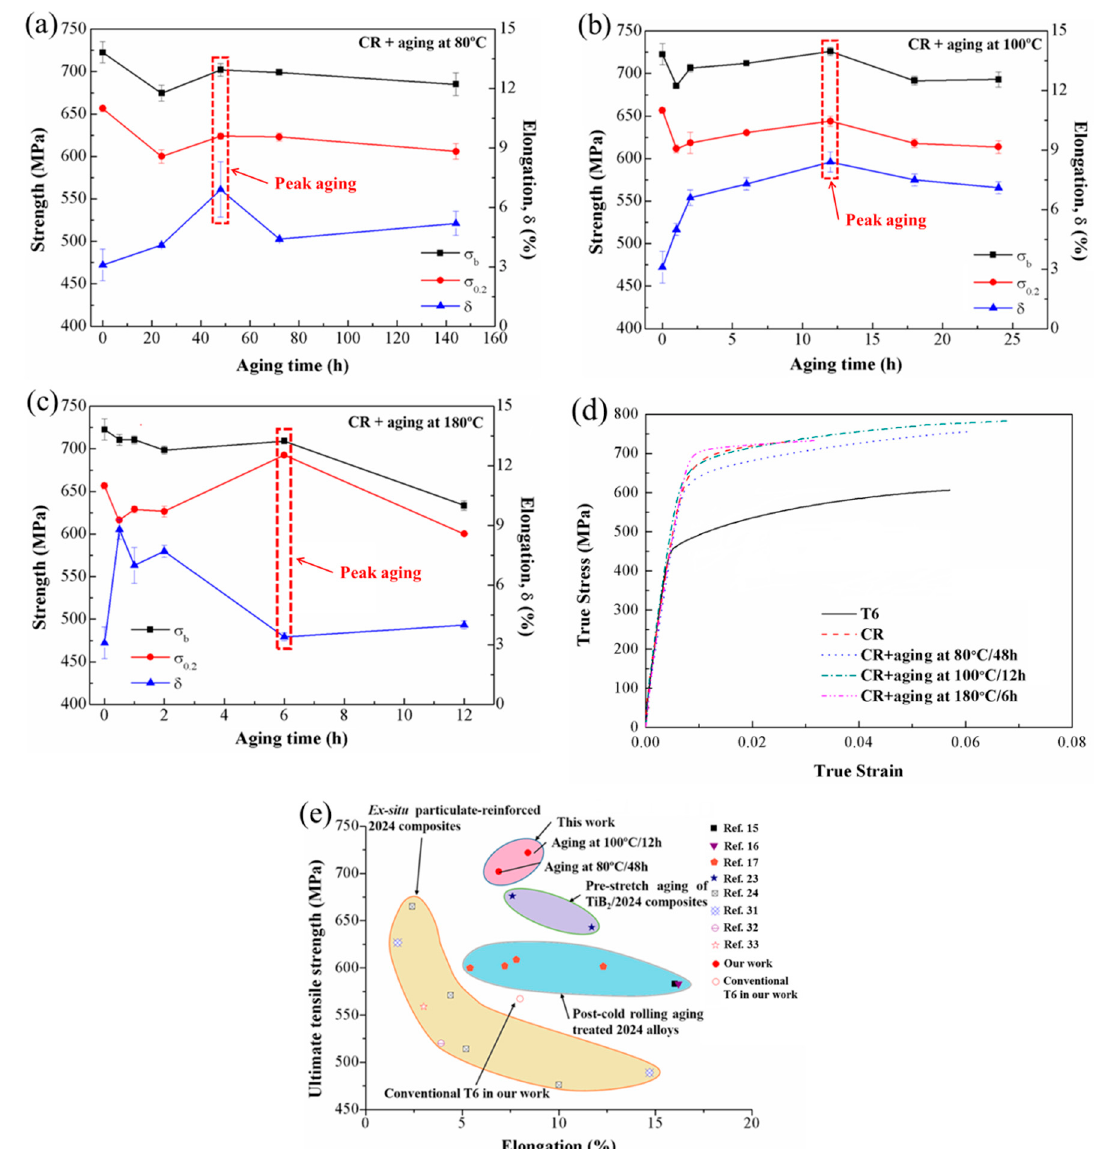
Figure 3. Tensile properties of in situ TiB 2 /2024 composite versus aging time of ( a ) 80 °C, ( b ) 100 °C, and ( c ) 180 °C, correspondingly (the red boxes indicate the peak aging of the given aging temperature). ( d ) True stress–strain curves of TiB 2 /2024 composites under different conditions. ( e ) Tensile properties of the TiB 2 /2024 composite in this work compared with the available literature data of 2024 alloys and particle-reinforced 2024 composites [15–17,23,24,31–33]. Table 1. Tensile properties of TiB 2 /2024 composites under different conditions.